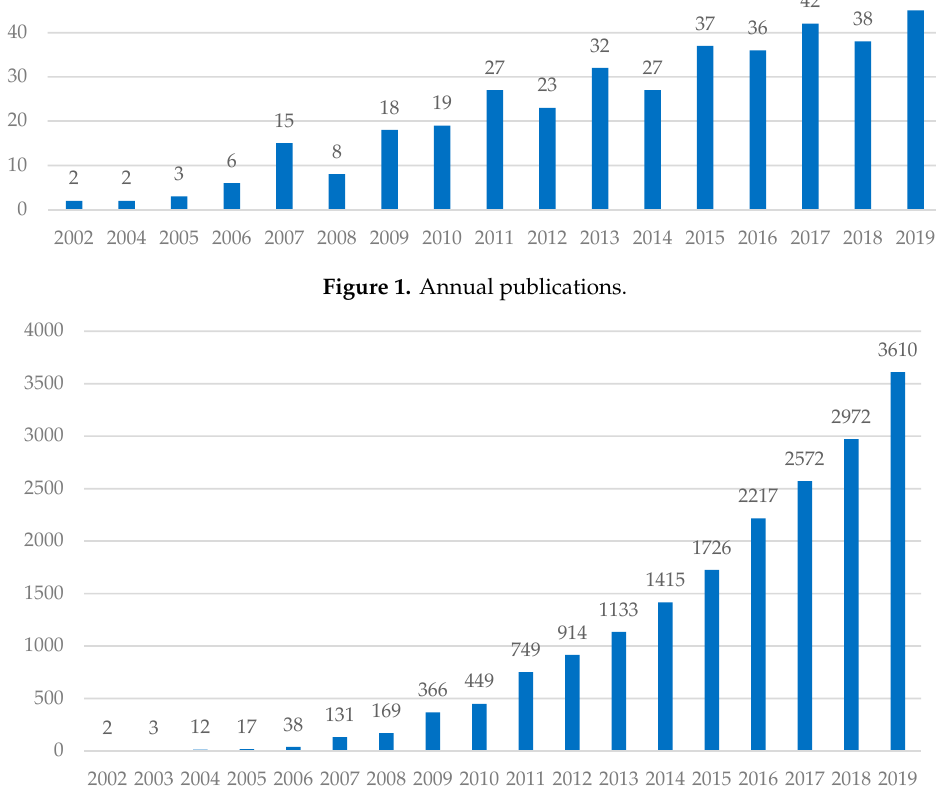
Figure 2. Annual Figure 2. Annual citations. Figure 2. Annual citations.